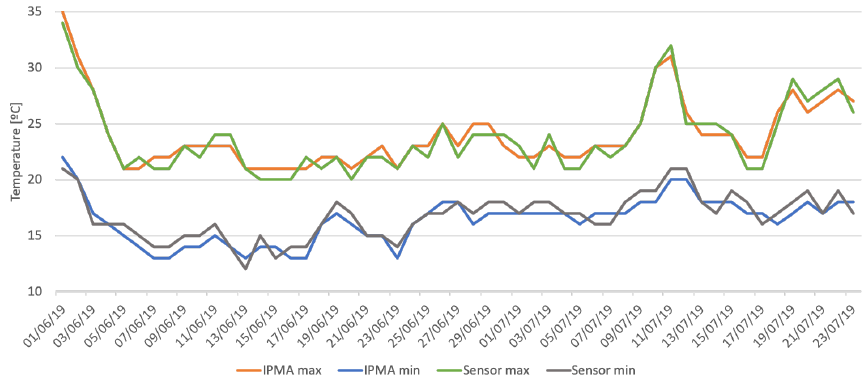
Figure 7. IPMA vs Sensor data comparison.